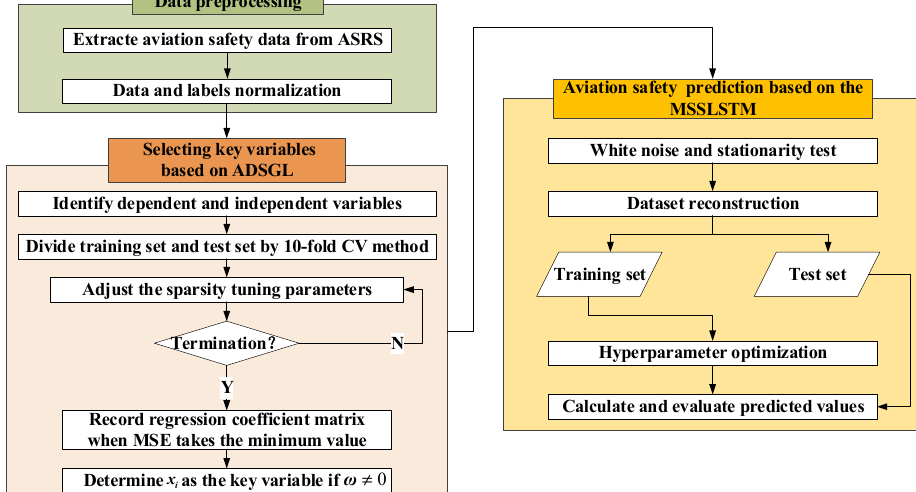
Figure 1. Flow chat of the ADSGL-MSSLSTM